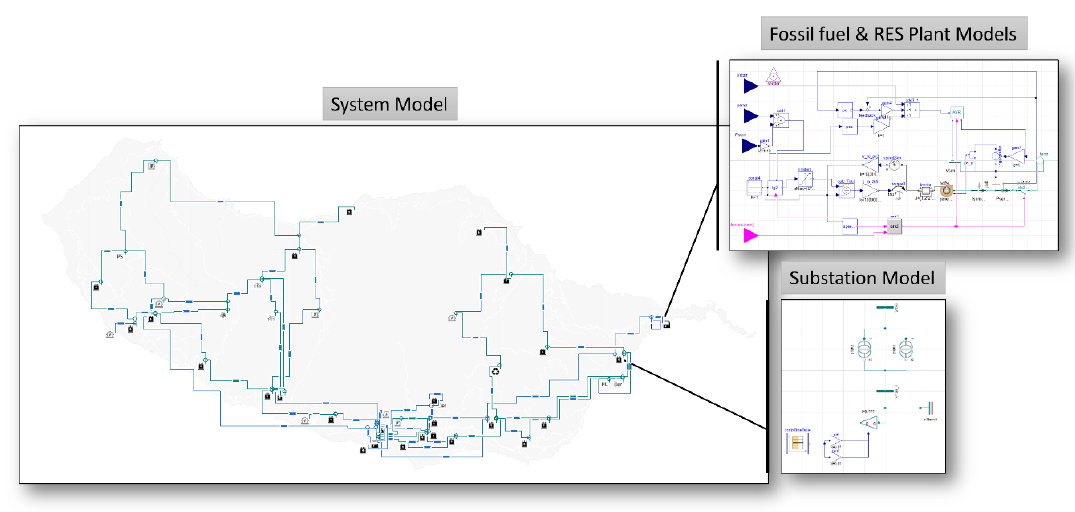
Figure 6. Madeira’s power system model in Modelica/Dymola.